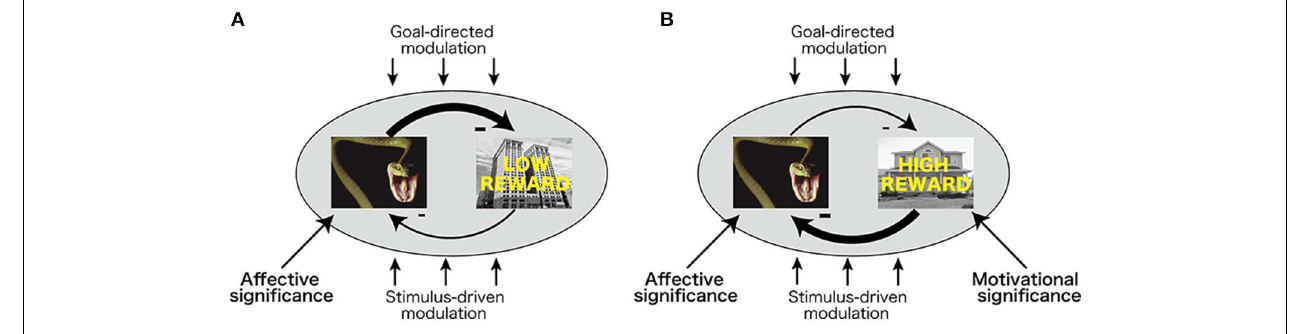
FIGURE 5 | Competition between affectively and motivationally significant stimuli. (A) During competition between high-arousal task-irrelevant negative stimuli and task-relevant stimuli with low motivational significance, negative stimuli dominate, thereby leading to